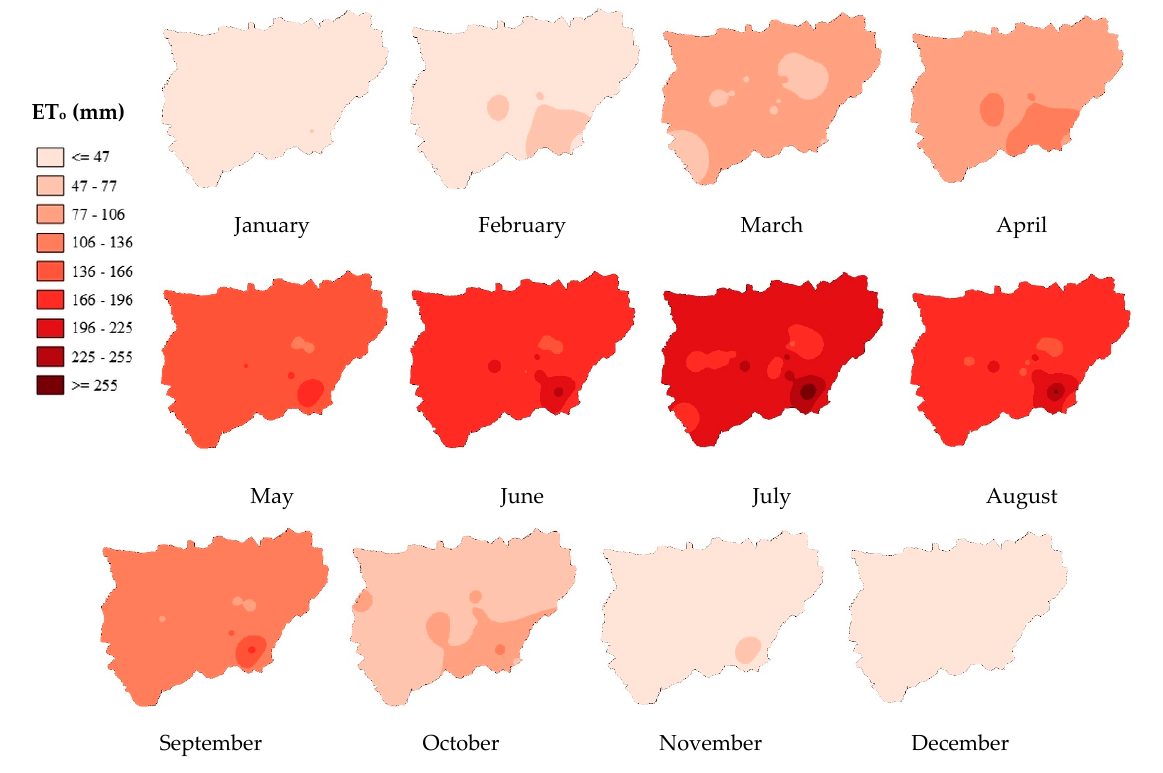
tember, where the south ‐ east zone presented the greatest values.